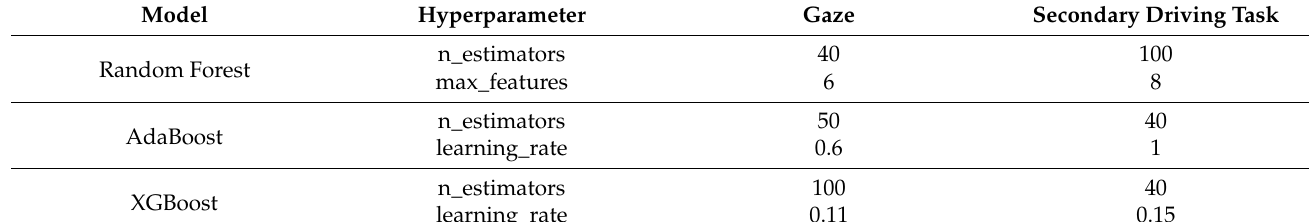
Table 10. Optimal hyperparameter values.